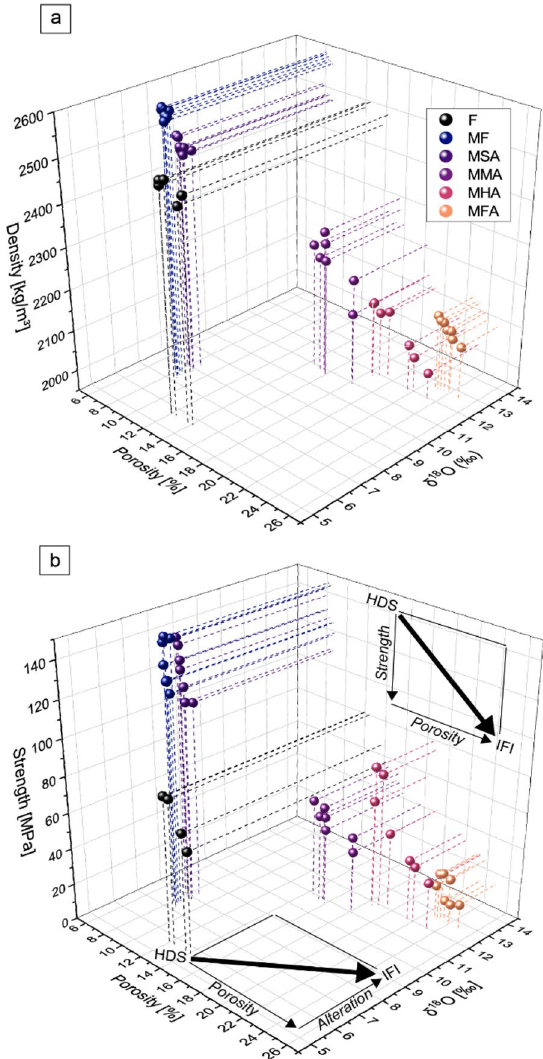
Figure 5. The influence of porosity and hydrothermal alteration on rock strength. ( a ) Density as a function of porosity (%) and oxygen isotope compositions (δ 18 O) as a proxy for degree of alteration for the variably-altered rocks collected from the Merapi dome. The unaltered but porous samples from the 2006 eruption are also shown (black symbols; F = fresh). Dotted lines are aids to help visual orientation. ( b ) Uniaxial compressive strength (MPa) as a function of porosity (%) and oxygen isotope compositions (δ 18 O) as a proxy for degree of alteration for the variably-altered rocks collected from the Merapi dome. Rock strength decreases as a function of degree of alteration and porosity (see also Supplementary Fig. S1) implying that edifice stability is controlled by a combination of porosity and hydrothermal alteration (see inset). HDS high dome stability, IFI increased flank